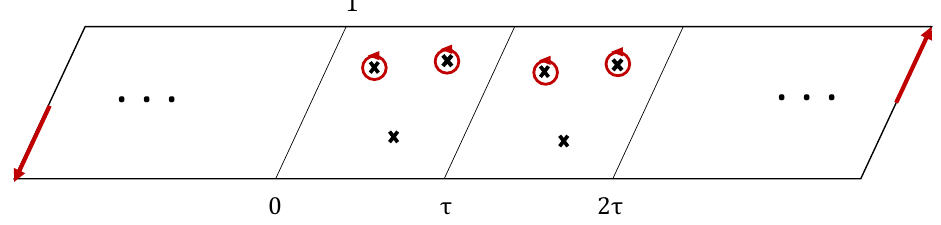
Figure 1 . Integration contour C (cid:17) for p > 0 in the rank-one case. The contour in the bulk R is determined by the JK residue. Two vertical segments represent the potential singularities at u = ! (cid:6) (cid:28) 1